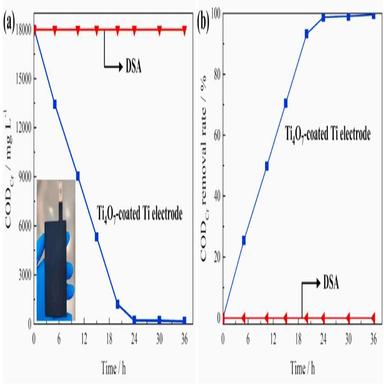
The relationship between (a) CODcr and (b) CODcr removal rate and treatment time of two electrodes used for electrochemical oxidation of 8 g L− 1 EGBE aqueous solution with the supporting electrolyte of 1 M NaNO3, respectively. The inset shows the digital photograph of the Ti4O7-coated Ti electrode.